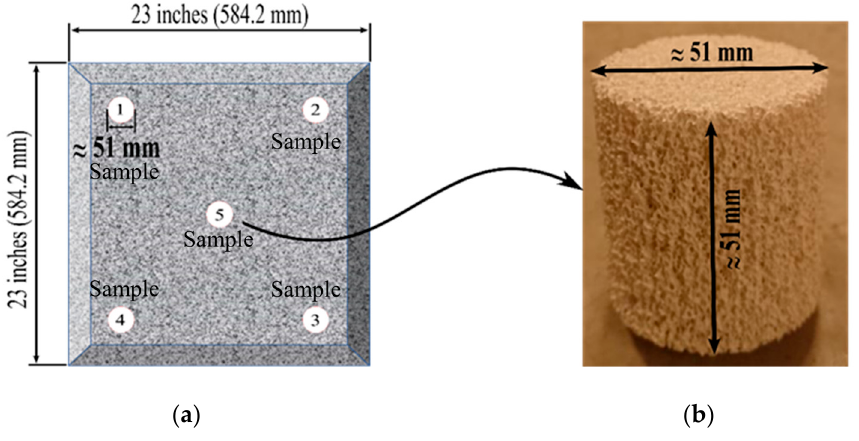
Figure 5. ( a ) Schematics of a Ceramic Foam Filer (CFF) block and the locations where the fi ve sam- ples were taken, ( b ) a cylindrical sample drilled from a CFF of Grade 50. were taken, ( b ) a cylindrical sample drilled from a CFF of Grade